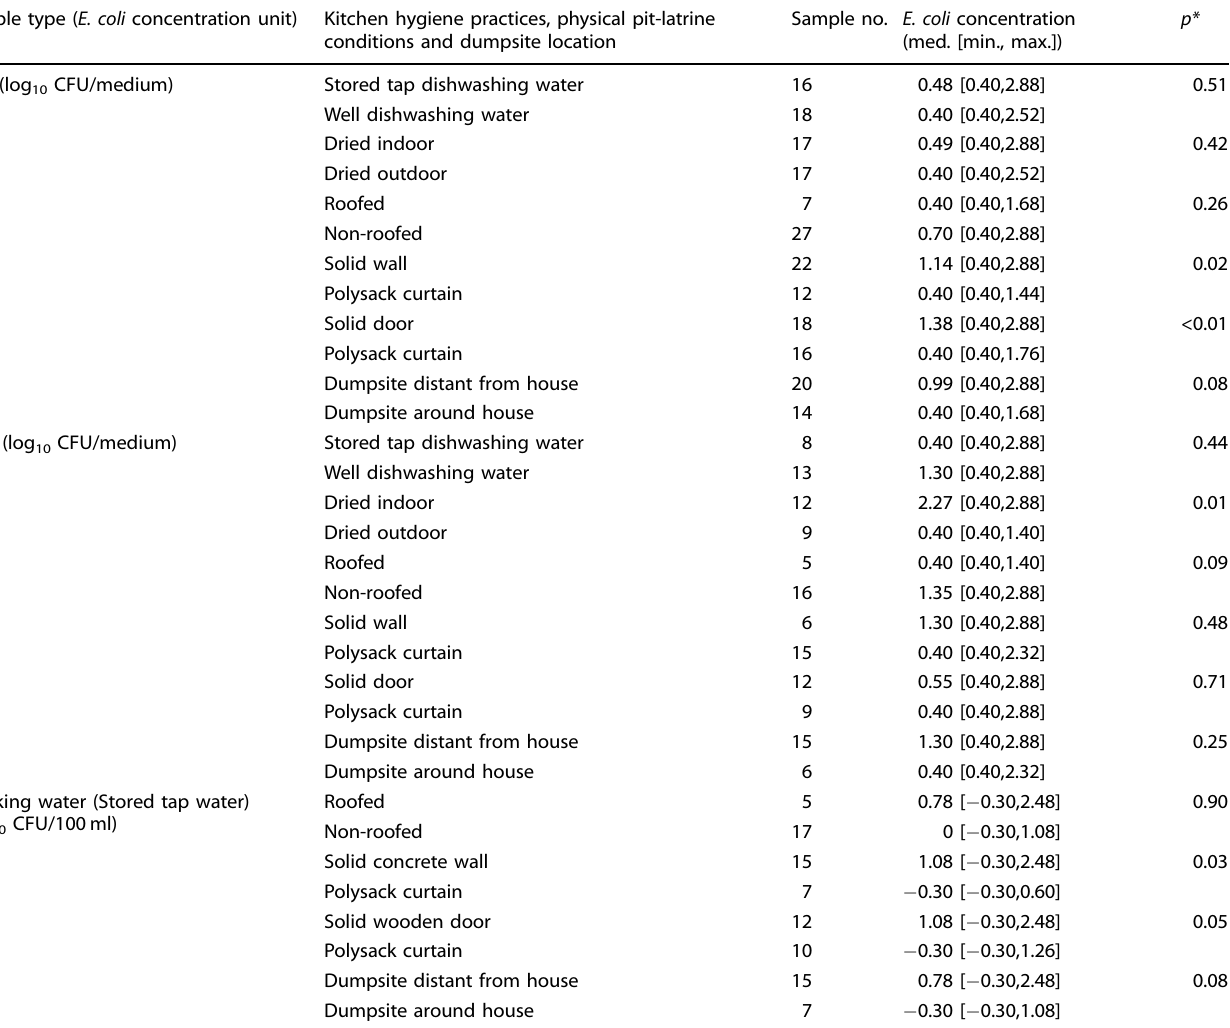
Table 4. Impact of kitchen hygiene practices, physical pit-latrine conditions, and dumpsite locations on E. coli concentration of cups, dishes, and drinking